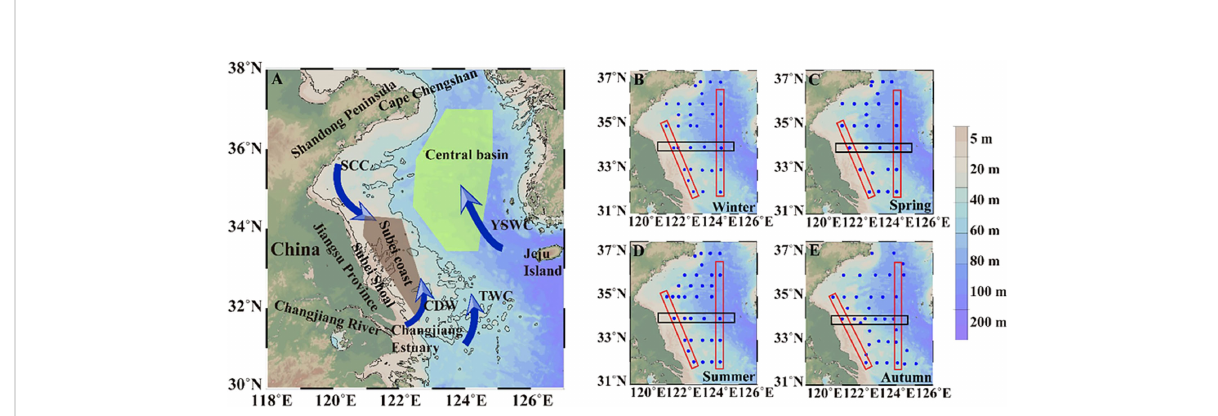
FIGURE 1 Area map and sampling stations. The Subei coast region and central basin are marked by colored polygons. The arrows in panel (A) denote the main ocean currents: SCC, Subei Coastal Current; CDW, Changjiang Diluted Water; TWC, Taiwan Warm Current; YSWC, Yellow Sea Warm Current. In panels (B – E) , red and black rectangles sketch those featured transects, including coastal and central sections (red rectangles) and the 34°N section (black